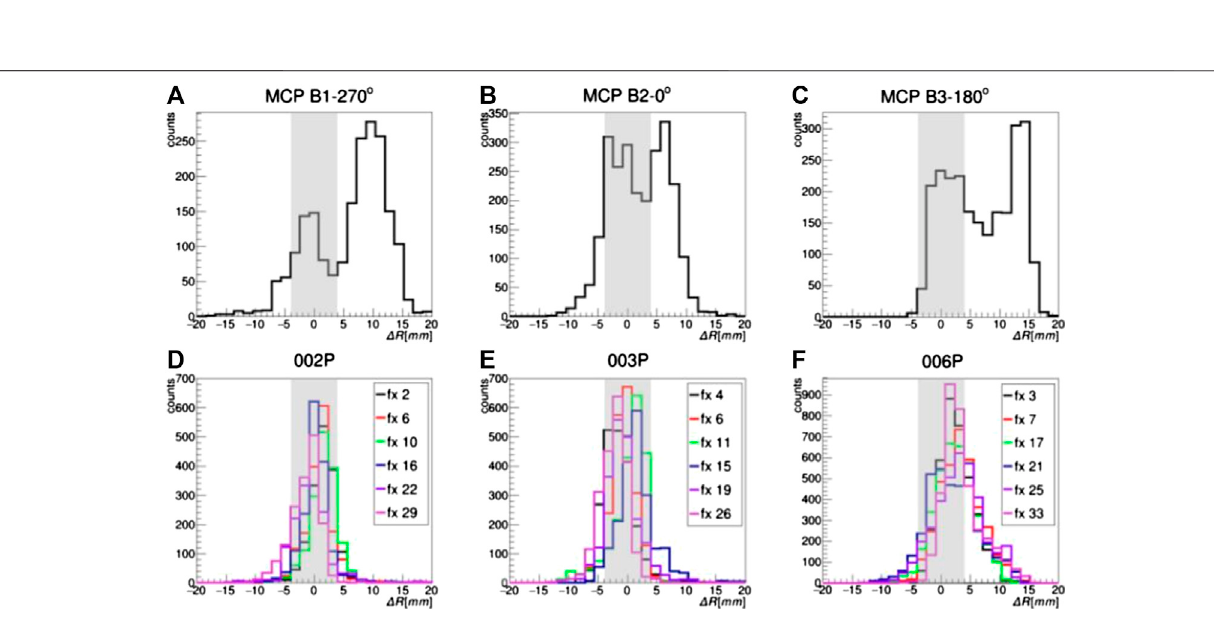
proposed CLUT, values included in this interval have been shown as transparent. Hence, values that are related to an increase of the particle range are drawn in yellow/red while values corresponding to a decrease are in light blue/blue. Due to experimental limitations and poor statistics in the activity